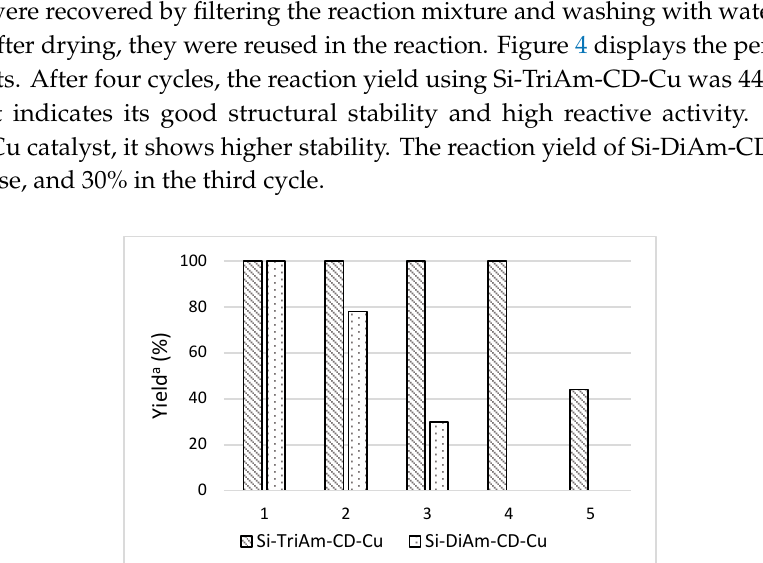
Figure 5. Infrared ( A ) and diffuse reflectance UV-Vis ( B ) spectra of (a) Si-TriAm-CD-Cu; (b) Si-TriAm- CD-Cu-exhaust. Before infrared measurements samples were outgassed at 80 °C to remove adsorbed water and impurities. Sample Si-TriAm-CD-Cu-exhaust was diluted in Teflon for Diffuse-Reflectance (DR) UV-Vis measurement. The corresponding curve was arbitrarily normalized to the intensity of the overtone/combination modes of the support (X 2.5). The peak labeled with * can be related to DMF residual solvent.